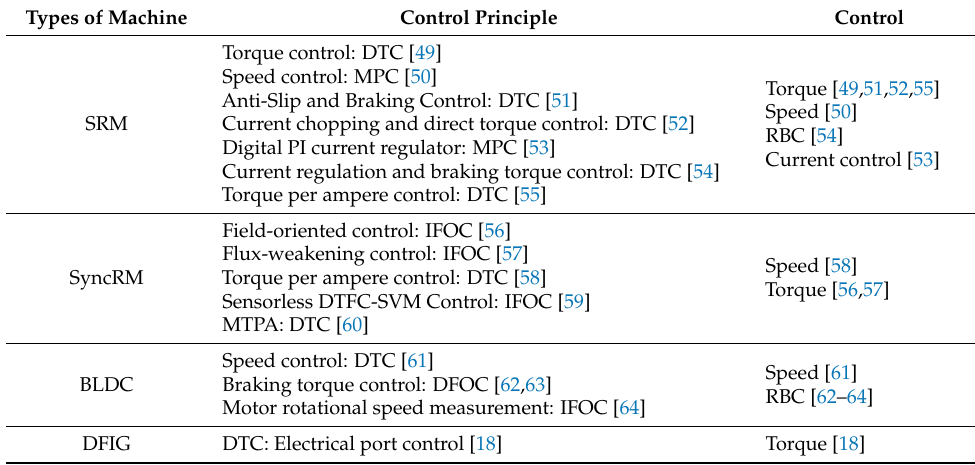
Table 3. Control strategies used in SRM, SyncRM, BLDC, and